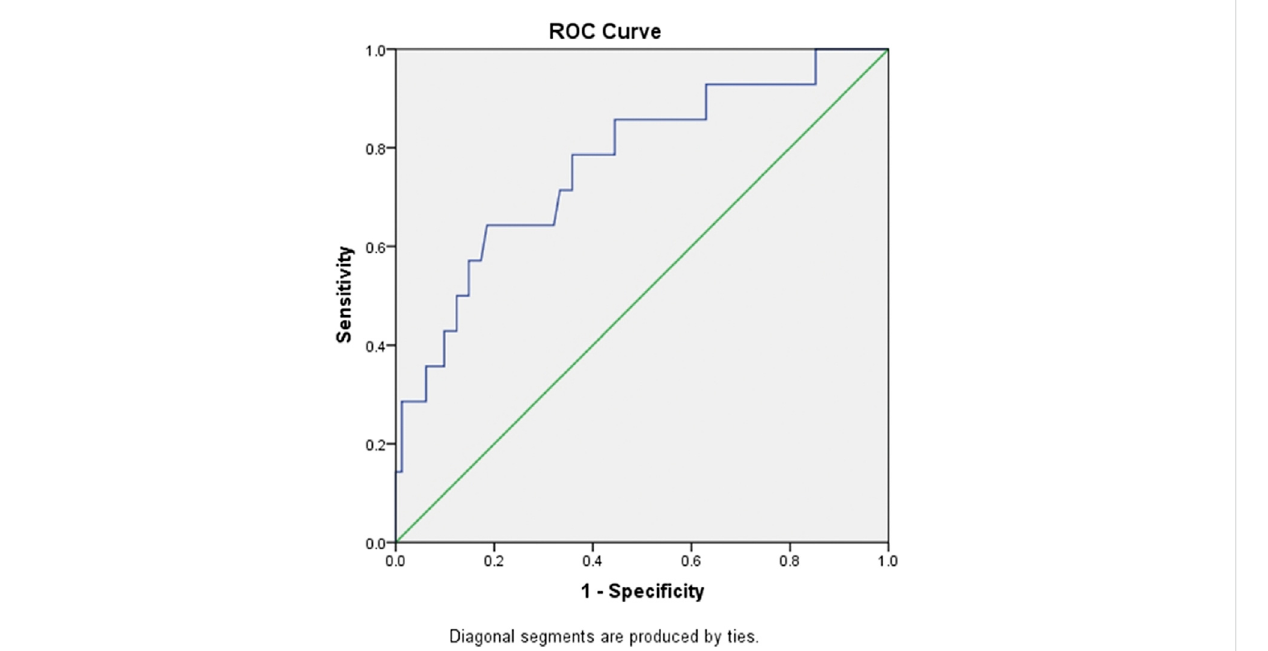
FIGURE 1 ROC curve of PLR for predicting mortality of in-hospital patients with COVID-19. Abbreviations: ROC, receiver operating characteristic; PLR, platelet/lymphocyte ratio.